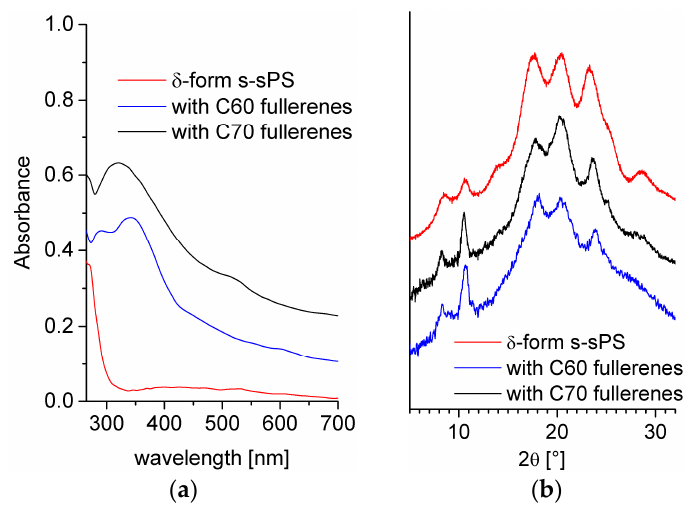
Figure 3. UV-Vis ( a ) and WAXD ( b ) spectra from different sPS films. The lines indicate sulfonated film with crystalline δ -form (red line), sulfonated (with crystalline δ -form) and loaded with C60 fullerenes (blue line), and sulfonated (with crystalline δ -form) and loaded with C70 fullerenes (black line).